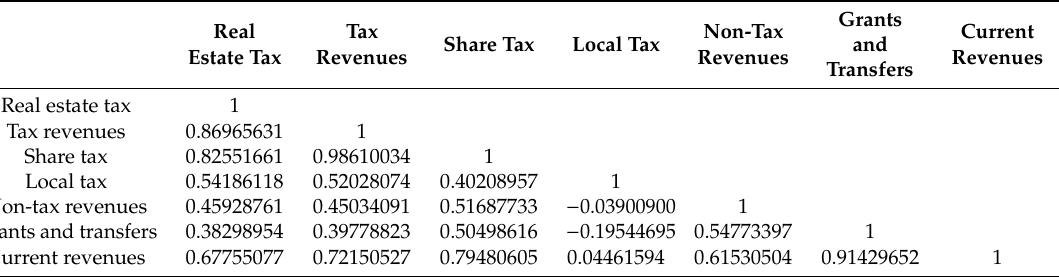
Share Tax Local Tax